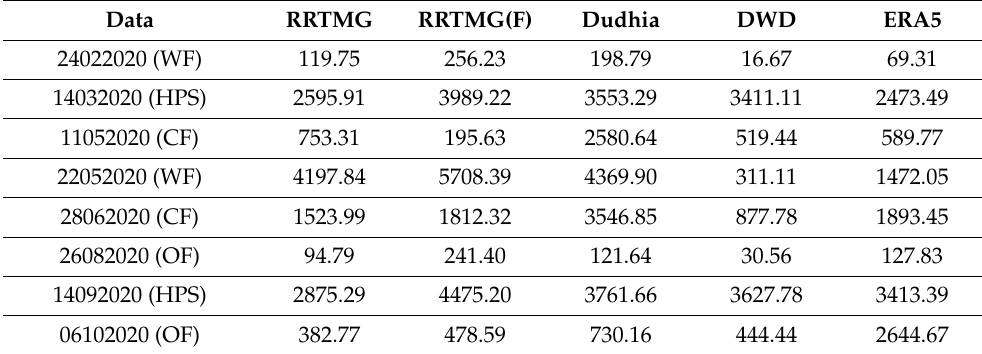
Table 15. Summary of daily values of direct radiation at Seehausen station [W · m − 2